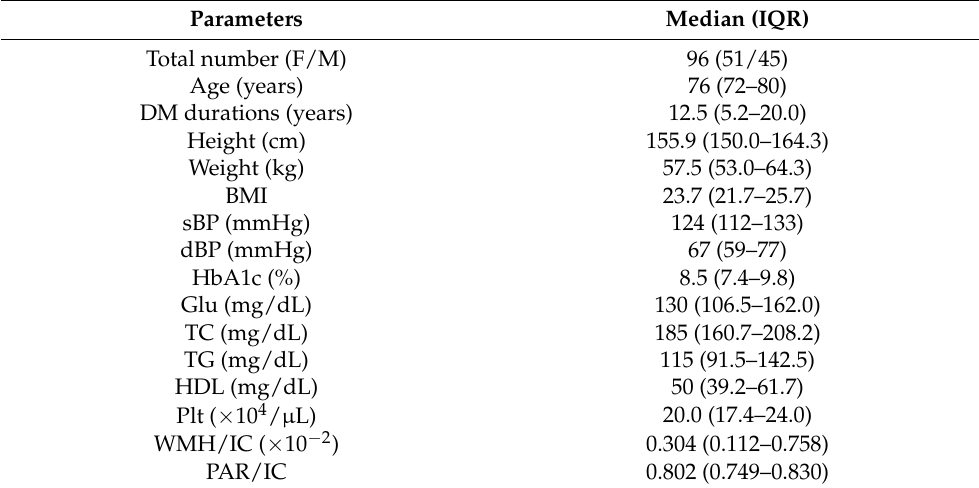
Table 1. Characteristics of the study